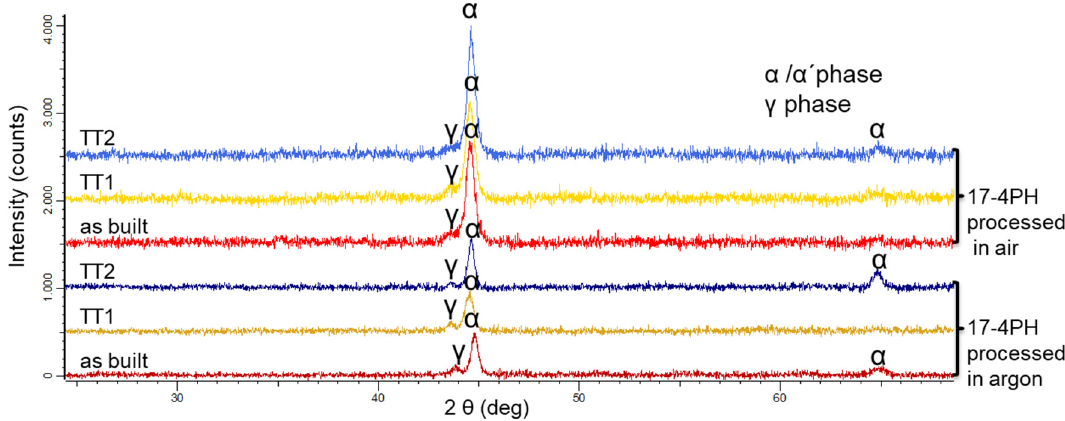
Figure 12. XRD patterns of 17-4PH specimens fabricated via PMD in air and argon analysed as built and after thermal treatment with TT1 and TT2.